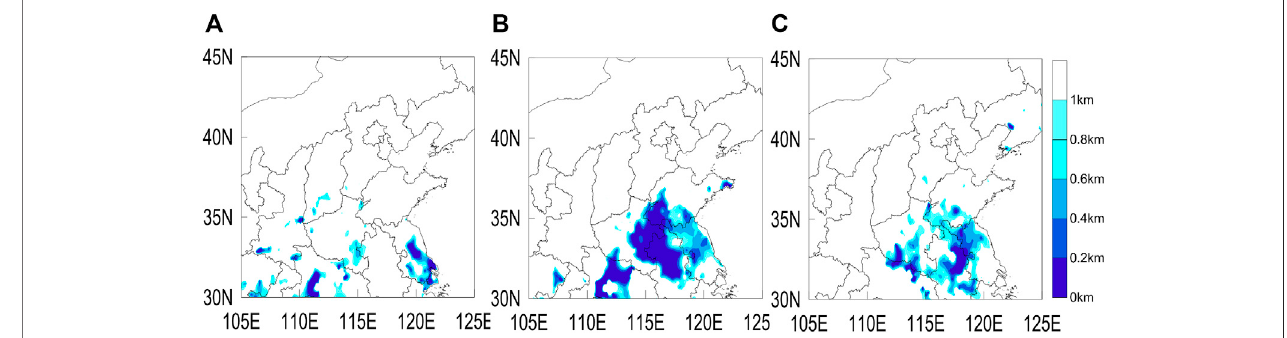
FIGURE 4 | Distributions of the daily visibility at 06:00 in Central-East China on 16 – 18 (A – C) January 2018.